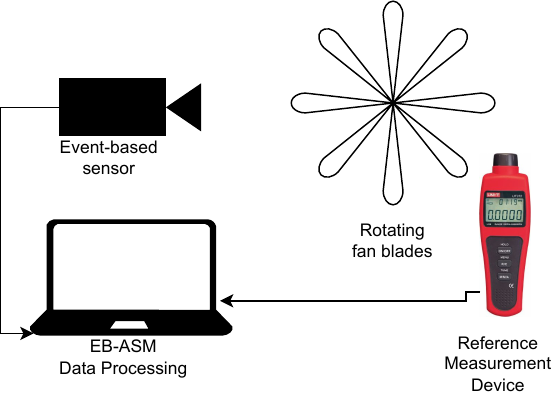
Figure 1. Schematic diagram of the proposed measurement system setup to record stream